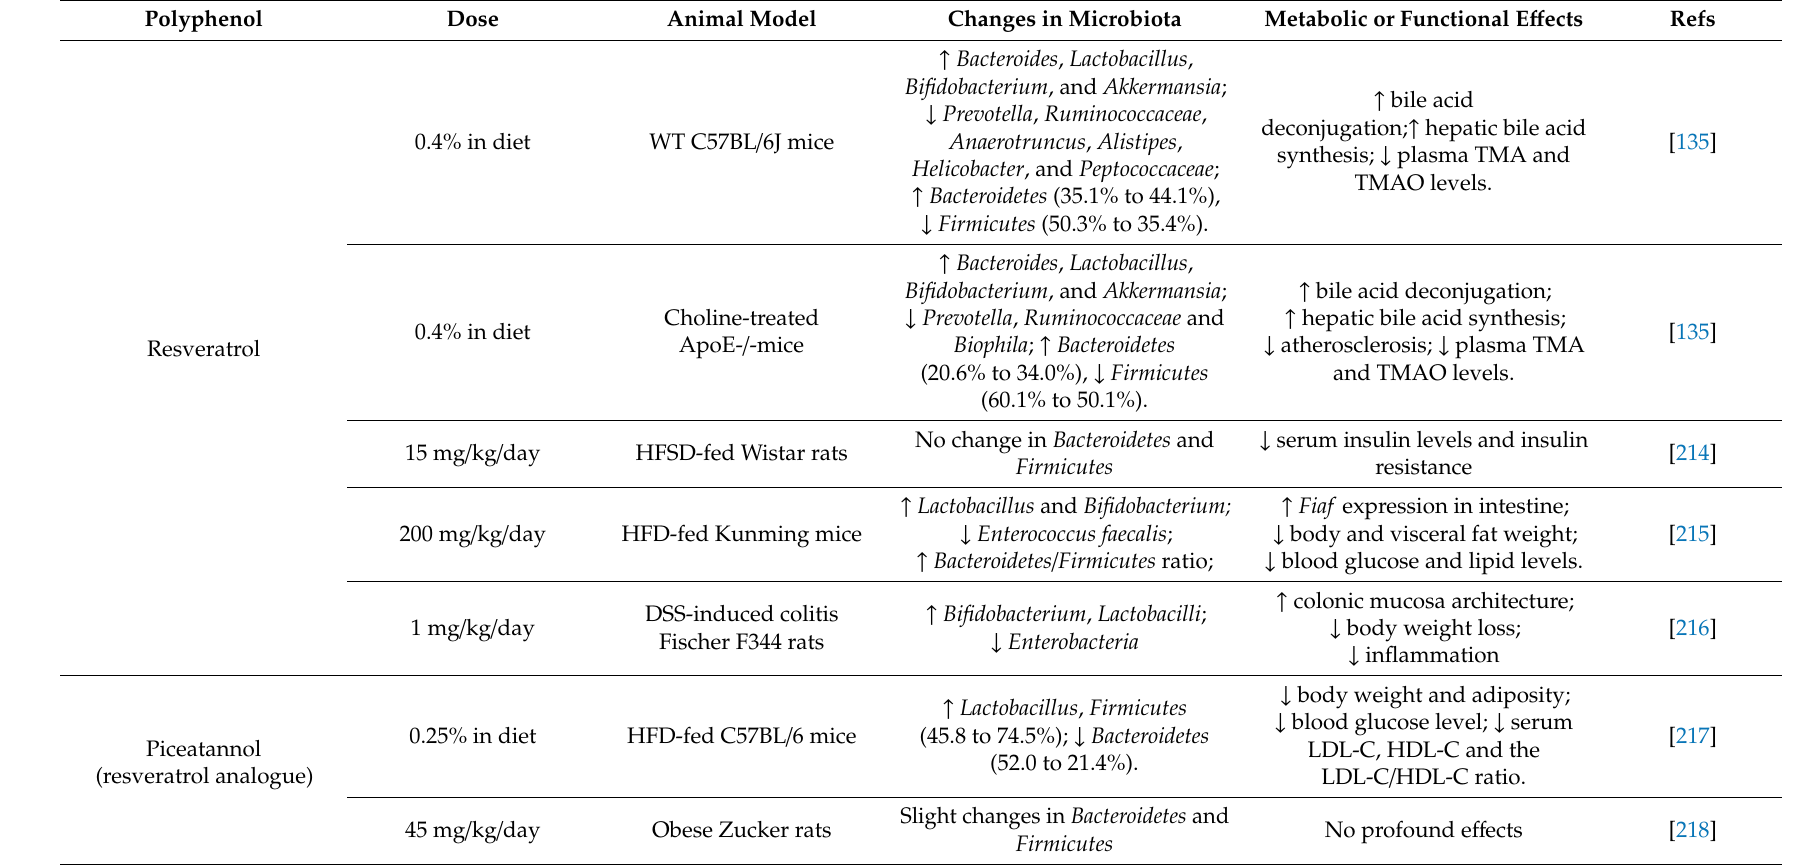
Table 2. E ff ect of polyphenols in di ff erent animal models of metabolic